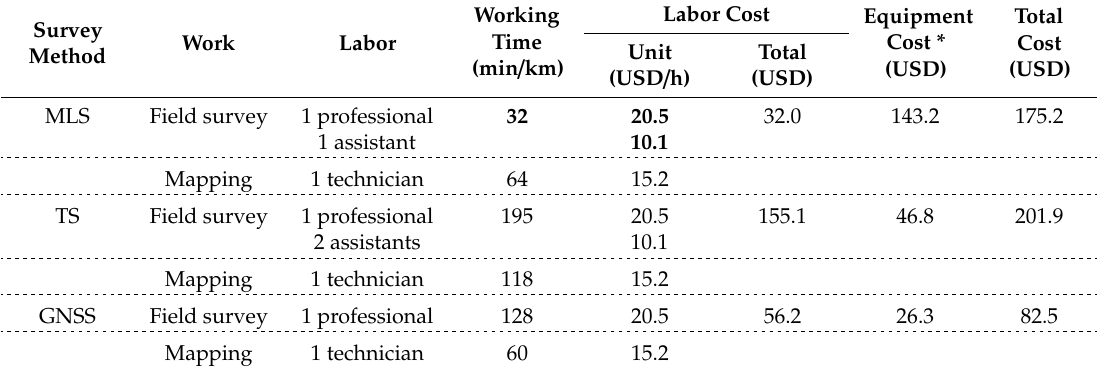
Table 7. Differences in the unit mean time and cost spent depending on the surveying methods in the four forest road routes.